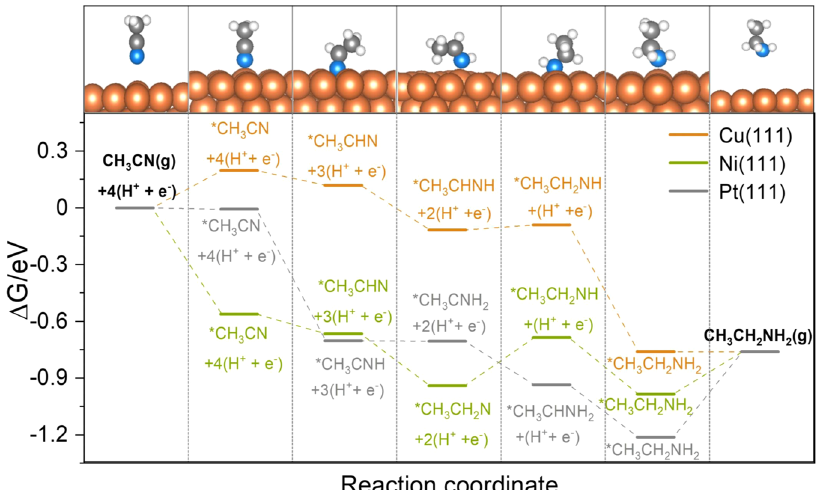
Fig. 5 DFT calculations. Free energy diagrams for CH 3 CN(g) electroreduction to CH 3 CH 2 NH 2 (g) along the most favorable pathway on Cu(111), Ni(111), and Pt(111) at an applied potential U = 0